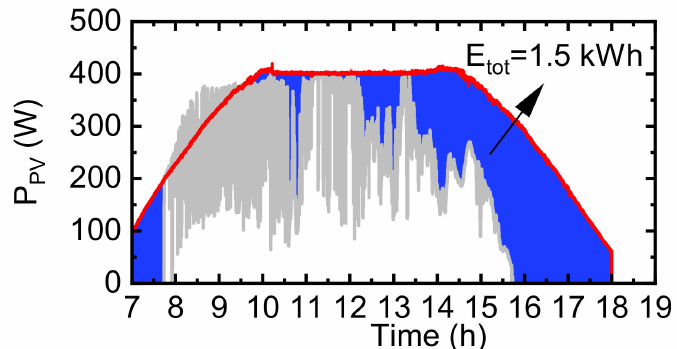
Figure A1. Total amount of energy required ( E tot ) over the entire day, indicating the energy capacity required from the